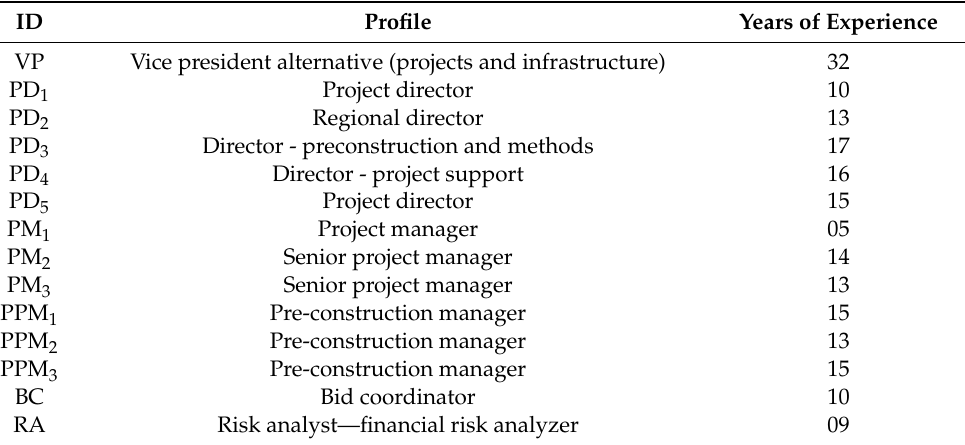
Table 8. Respondents’ profiles.